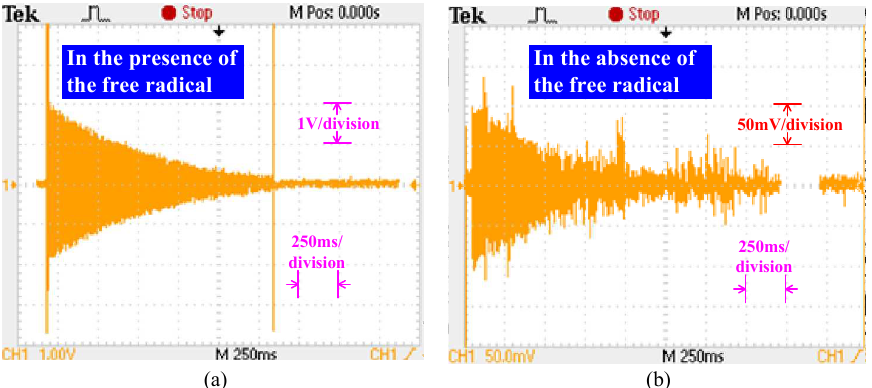
Figure 14. Comparison results of the free induction decay (FID) signal. ( a ) In the presence of the free radical; ( b ) in the absence of the free